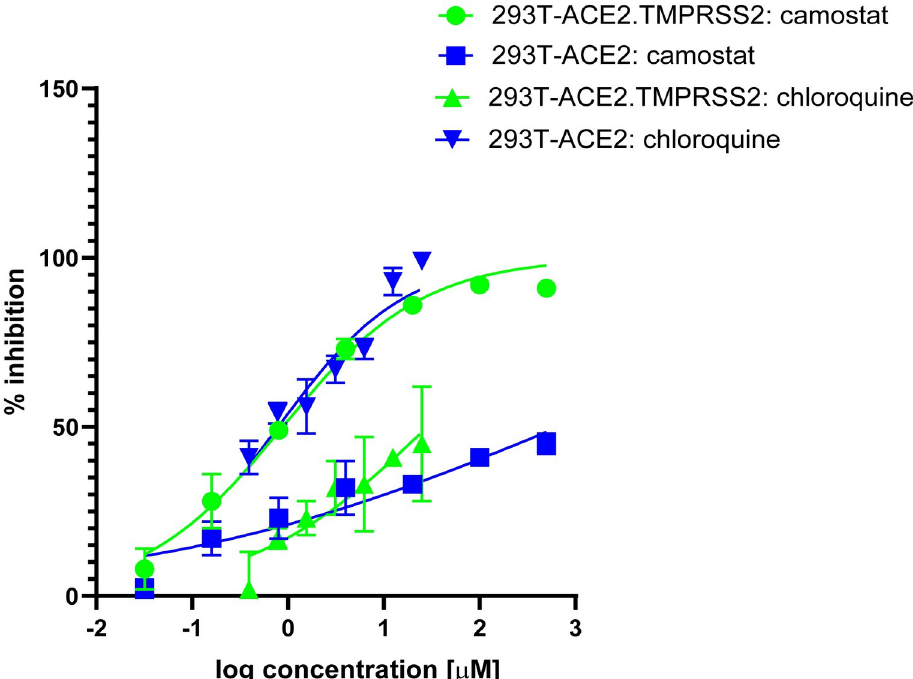
Fig 3. pH-dependent and -independent pathways of cell entry of SARS-CoV-2 S pseudoviruses. Camostat mesylate inhibits TMPRSS2 activity and chloroquine inhibits endosomal acidification required for cathepsin activity. Cells were pretreated with camostat mesylate or chloroquine for 2 h prior to pseudovirus infection in the presence of inhibitor for a period of 48 h. X-axis indicates log concentration of inhibitor. Y axis indicates percentage inhibition compared to pseudovirus infection without inhibitor treatment. Results shown are representative of three independent